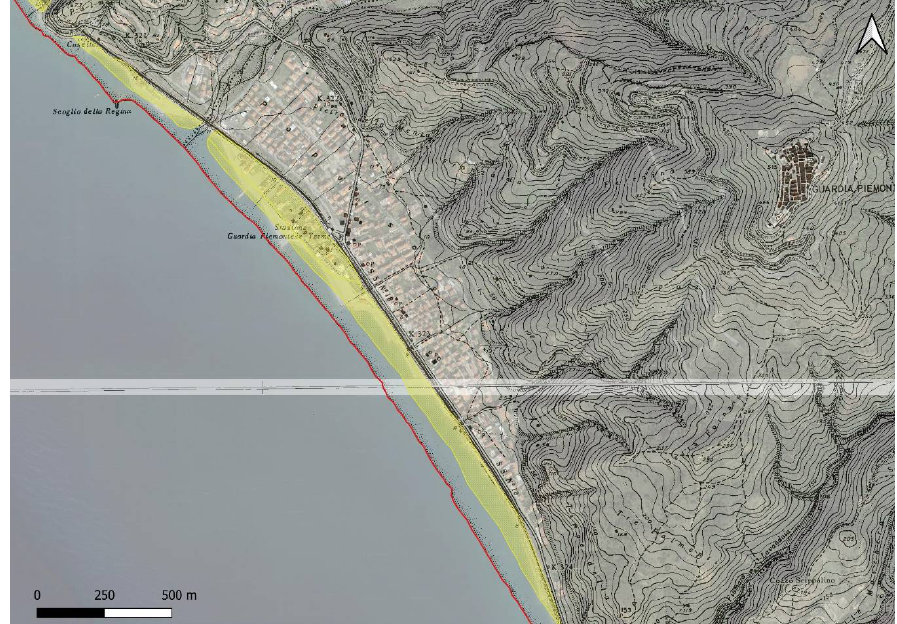
Figure 5. Guardia Piemontese: overlap between CASMEZ cartography and most recent Google satellite image. Legend: red line = shoreline of 1954; yellow dotted area = dune systems of 1950s.